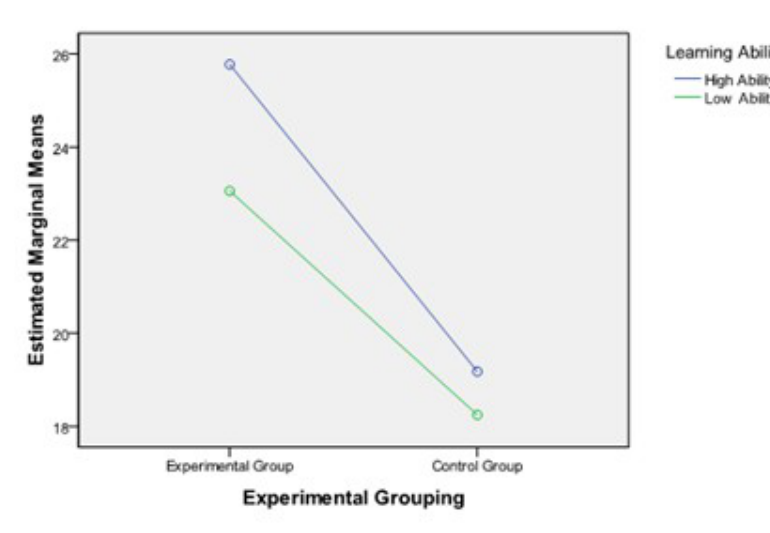
Figure 2. Estmated marginal mean of the post-test scores